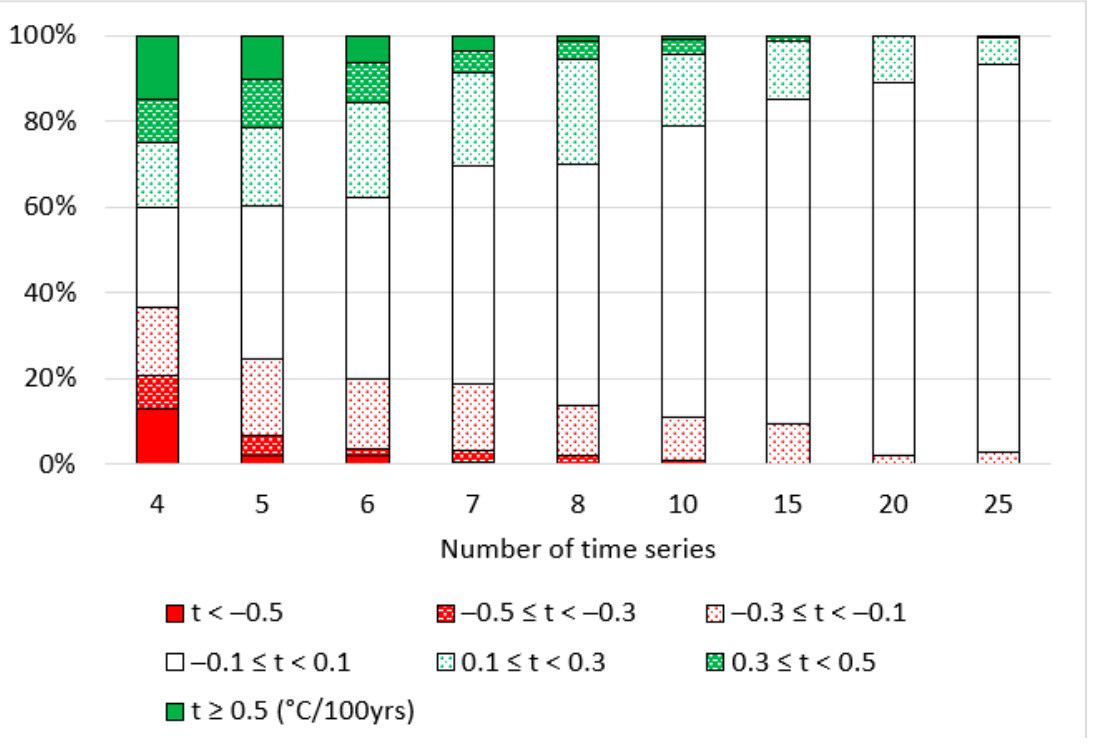
Figure 3. Frequency distribution of network mean trend error reduction (t) using °C/100 yrs unit. Green (red) color indicates improvement (worsening).